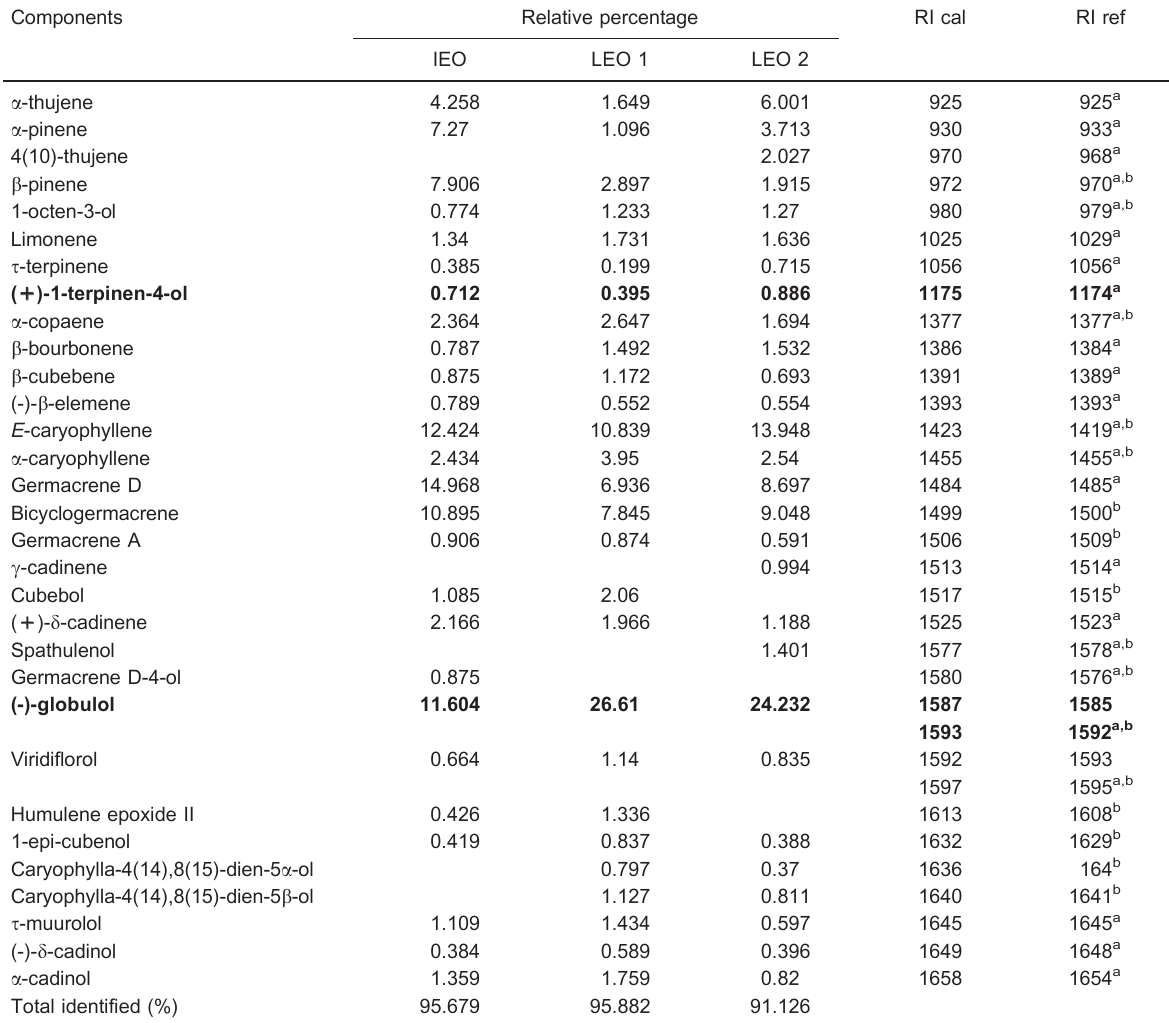
Table 1. Chemical composition of essential oils (EO) of Hyptis mutabilis .